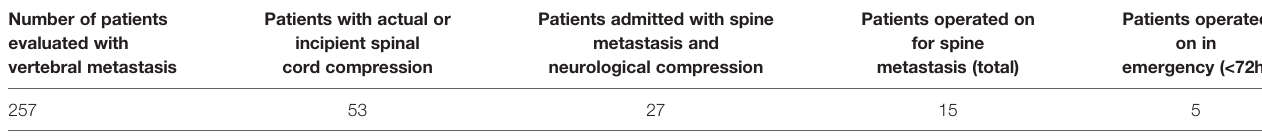
TABLE 3 | Strati fi cation of patients with vertebral metastases who were evaluated at the Spine and Spinal Cord Surgery department in the year 2021. Number of patients evaluated with vertebral